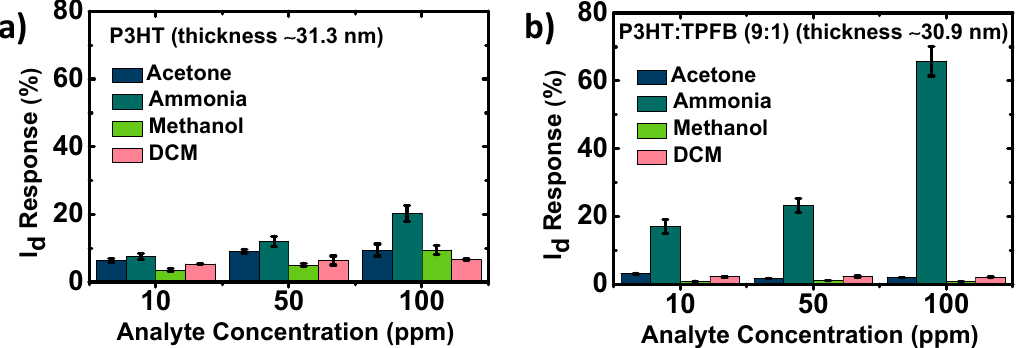
Figure 4. Selectivity of the sensors consisting of the thin polymer films of ( a ) P3HT and ( b ) P3HT:TPFB (9:1). The current was recorded at the gate voltage of − 100 V. The film thickness was set to ~31